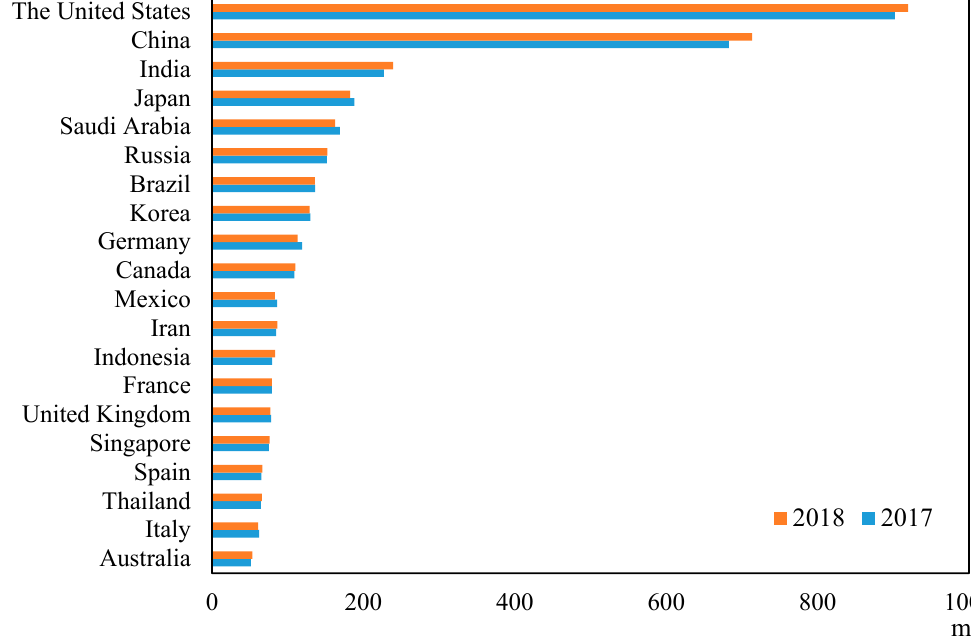
Figure 2. Top 20 countries with the highest oil consumption.